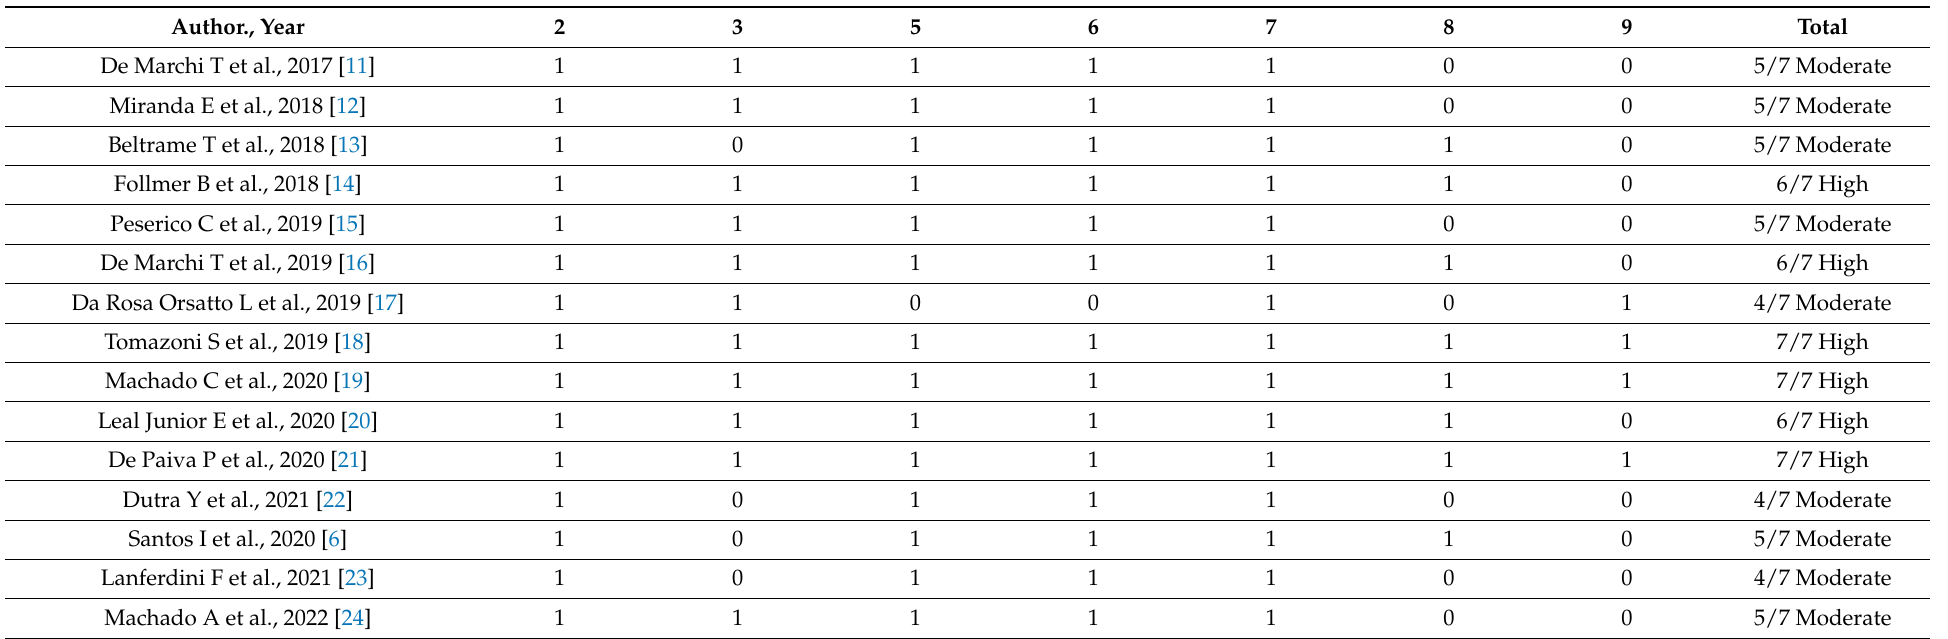
Table 3. RCTs’ internal